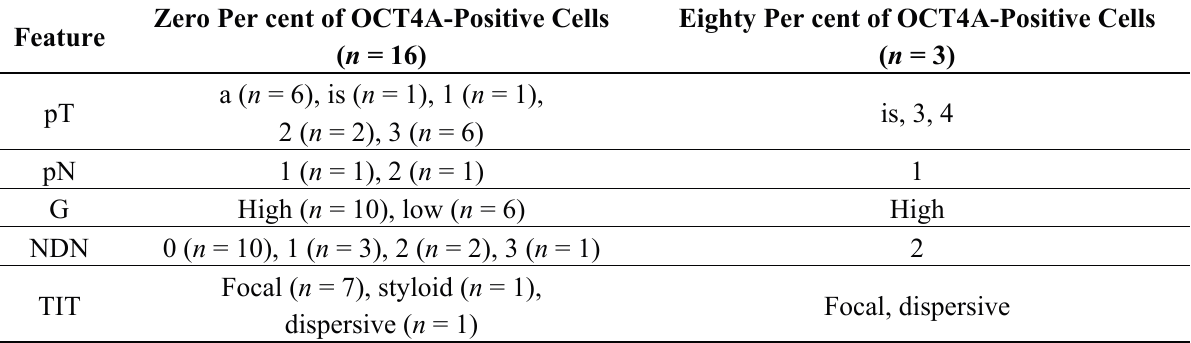
Table 2. Characteristics of patients without OCT4A-positive cells and with 80% of OCT4A-positive cells. pT, pathological assessment (p) classifying the extent of cancer spread (T) by WHO TNM Classification of Malignant Tumours; pN, pathologic lymph node status; G, grading; NDN, non-classic differentiation number; TIT, tissue invasion type; n, number of cases.